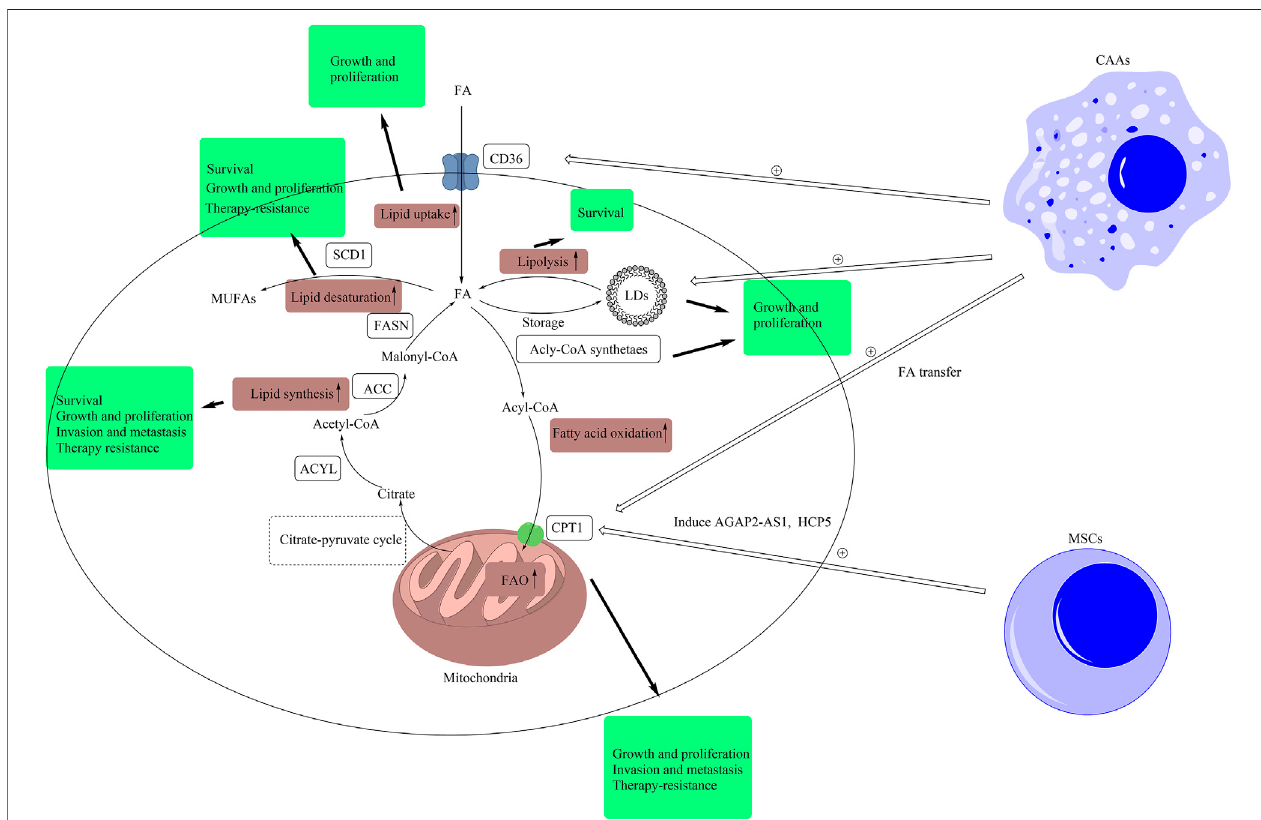
FIGURE 1 | Lipid signals alteration in CSCs and TME. Intracellular lipid signals comprise of lipid uptake, lipolysis, fatty acid oxidation, lipid synthesis, lipid desaturation, and lipid peroxidation. In this fi gure, we have brie fl y exhibited the pathways of lipid uptake, lipolysis, fatty acid oxidation, lipid synthesis, and lipid desaturation. The metabolic products of other forms of metabolism, such as citrate produced in glucose metabolism, are transported out of mitochondria by citrate- pyruvate cycle. Then, citrate is converted to malonyl-CoA by the catalysis of ACLY and ACC. Malonyl-CoA is used by FASN to synthesize FAs. Redundant FAs result from de novo synthesis anduptakebyCD36arestored inLDs,and LDs provideFAs bylipolysis.Fatty acidscanbeconverted intoacyl-CoA, and thelatter canbe transported into mitochondria by CPT1 for fatty acid β -oxidation. Besides, SCD1 can catalyze FAs into MUFAs. In CSCs, these pathways are abnormally upregulated. The pathway of lipid synthesis is closely related with the stemness features, including cell growth and proliferation, invasion and metastasis, and resistancetotherapy, in CSCs. The inhibition oflipid synthesis inducesthe death ofCSCs. Theupregulation of lipid desaturation supportsthe growth, proliferation, and resistance to therapy in CSCs. Inhibiting SCD1 improves the sensibility of CSCs to ferroptosis. The higher level of LDs promotes the growth and proliferation of CSCs. Blockage of lipolysis leads to the death of CSCs. The upregulation of lipid uptake supports the growth and proliferation of CSCs. The upregulation of FAO has a positive effect on the growth, proliferation, invasion, metastasis, and resistance to therapy in CSCs. Extracellular lipid signals in TME also support the stemness of CSCs. Mesenchymal stem cells induce the expression of AGAP2-AS1 and HCP5 to elevate FAO in CSCs to support the stemness of CSCs. Besides, CAAs improve the levels of LDs and the expression of CPT1 and CD36 by secreting cell factors or lipid transfer to support the stemness of CSCs. (ACLY, ATP citratelyase;ACC, acetyl-CoAcarboxylase; CAA,cancer-associated adipocytes;FA,fattyacid;FAO, fattyacid oxidation;FASN, fattyacidsynthase; CD36,cluster of differentiation 36; LD, lipid droplet; CPT1, carnitine palmitoyltransferase-1; MUFA, monounsaturated fatty acid; MSC, mesenchymal stem cell; SCD1, stearoyl- CoA desaturase 1; TME, tumor